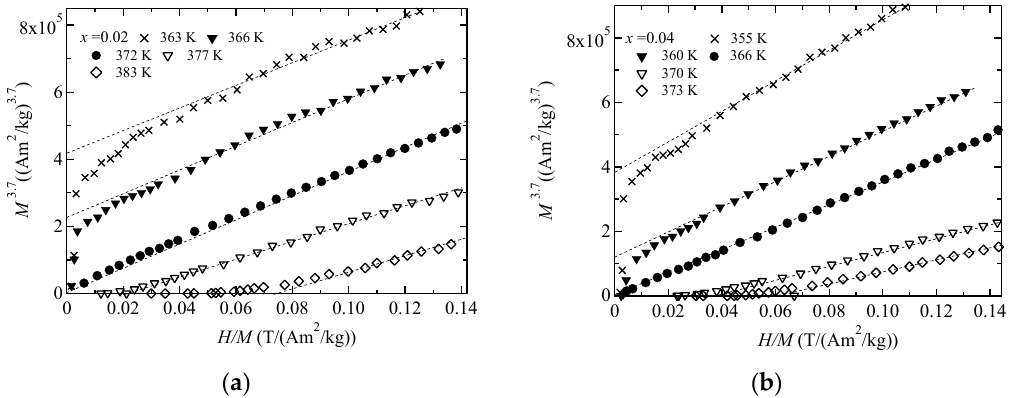
Figure 2. The H / M dependences of M 2 for ( a ) x = 0.02 and ( b ) x = 0.04. The dotted straight lines are included as a visual guide.